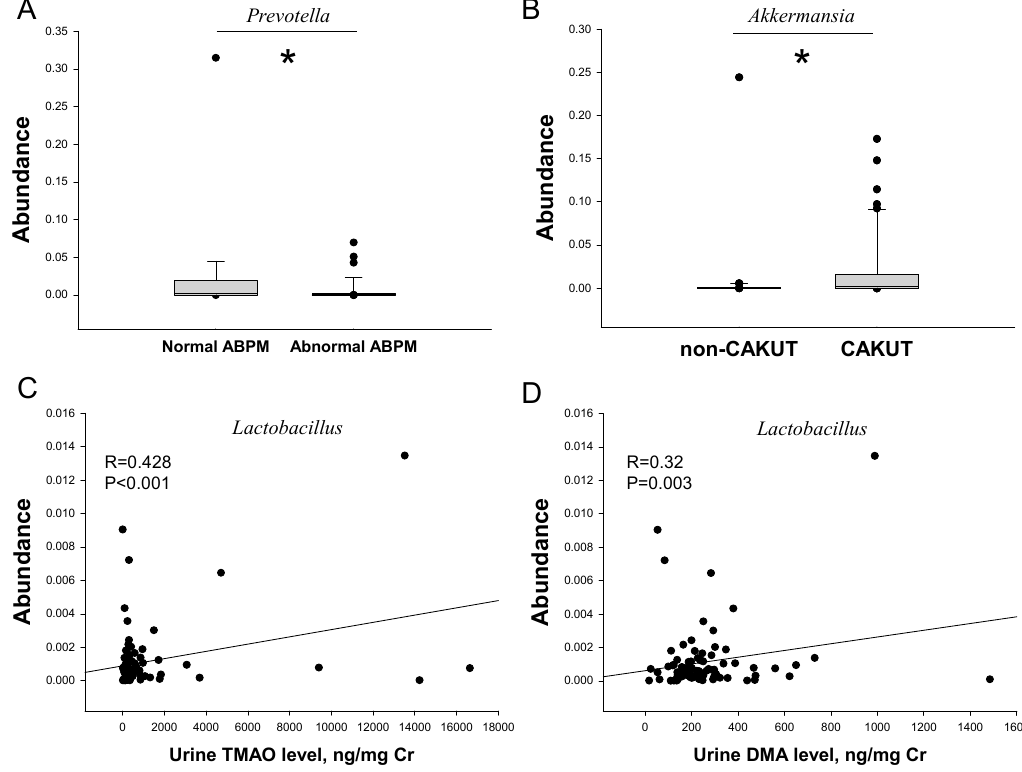
Figure 2. (A) Abundance of genus Prevotella in CKD children with normal vs. ABPM. (B) Abundance of the Akkermansia genus in CKD children with CAKUT vs. non-CAKUT. Correlations between abundance of the Lactobacillus genus, (C) urinary TMAO level, and (D) DMA level. * p < 0.05 by the Mann–Whitney U-test. The symbol of blackball indicates each recruiting participant.